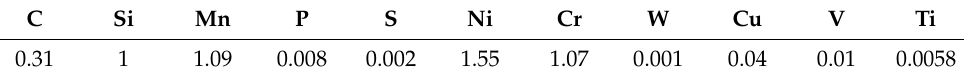
Table 1. Chemical composition of 30CrMnSiNi2A (wt %).